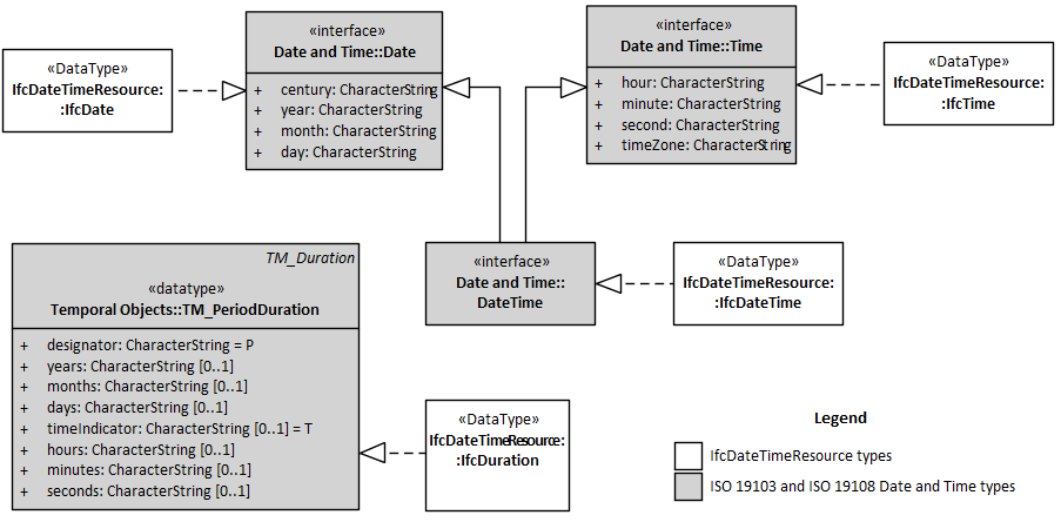
Figure 14. UML class diagram showing IFC Date and time types as realizations of ISO 19103 and ISO 19108 datatypes.